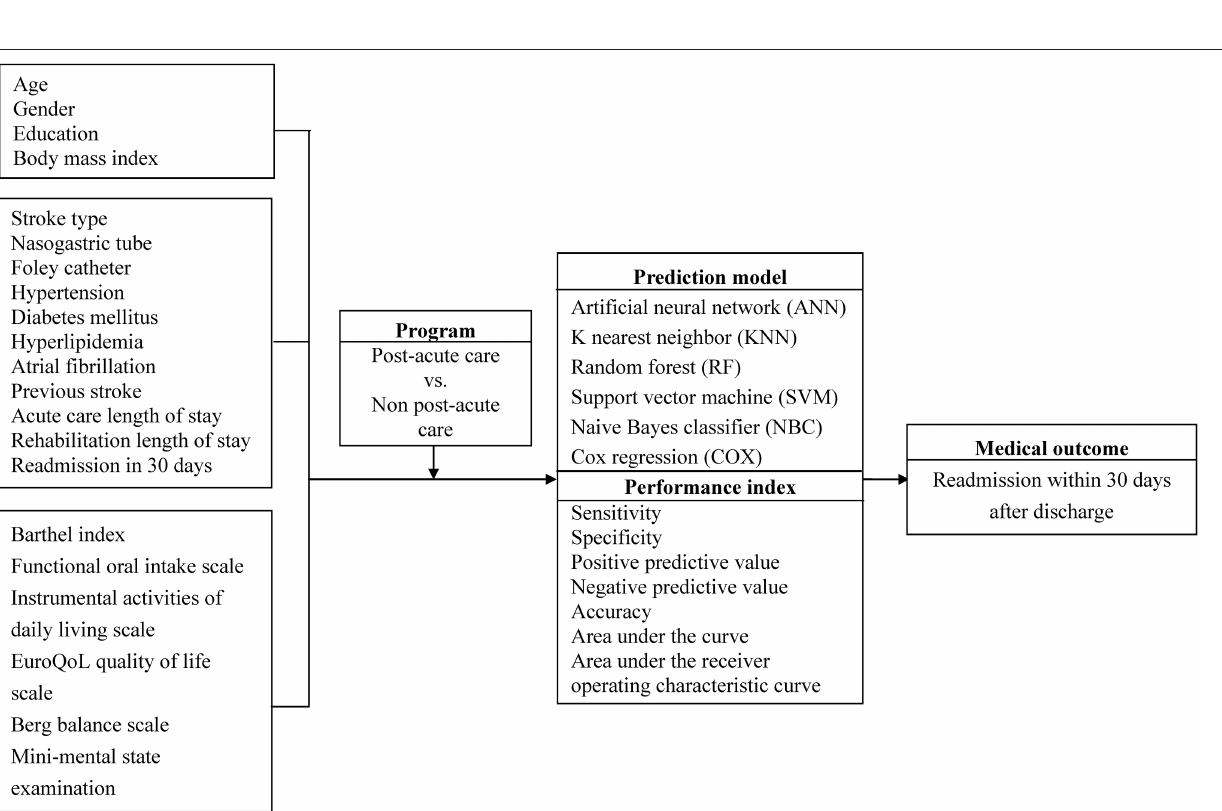
FIGURE 2 | Conceptual framework of the proposed method for predicting readmission within 30 days after stroke.